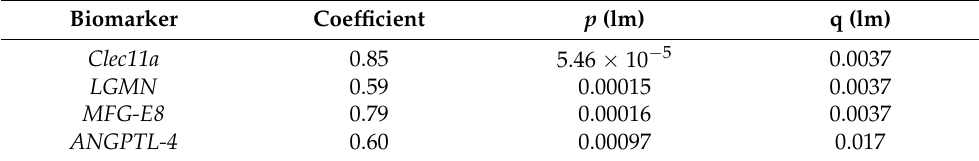
Table 2. Differences in spinal CSF biomarker concentrations between TN patients and